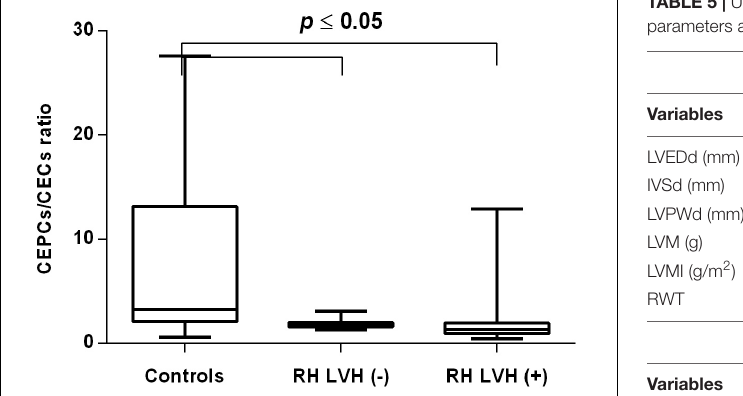
FIGURE 6 | CEPCs/CECs ratio in patients with and without LVH belonging to RH group. Box and whisker plots show median (central line), upper and lower quartiles (box) and range excluding outliers (whiskers). Data were analyzed using Kruskal-Wallis test followed by the Dunn’s multiple comparison test. P ≤ 0.05 was considered statistically significant.